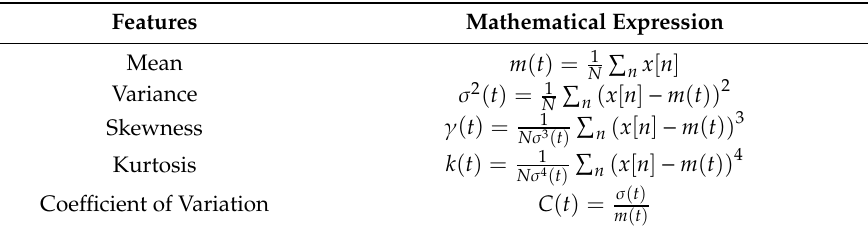
Table 1. Time-domain features with their mathematical expression.